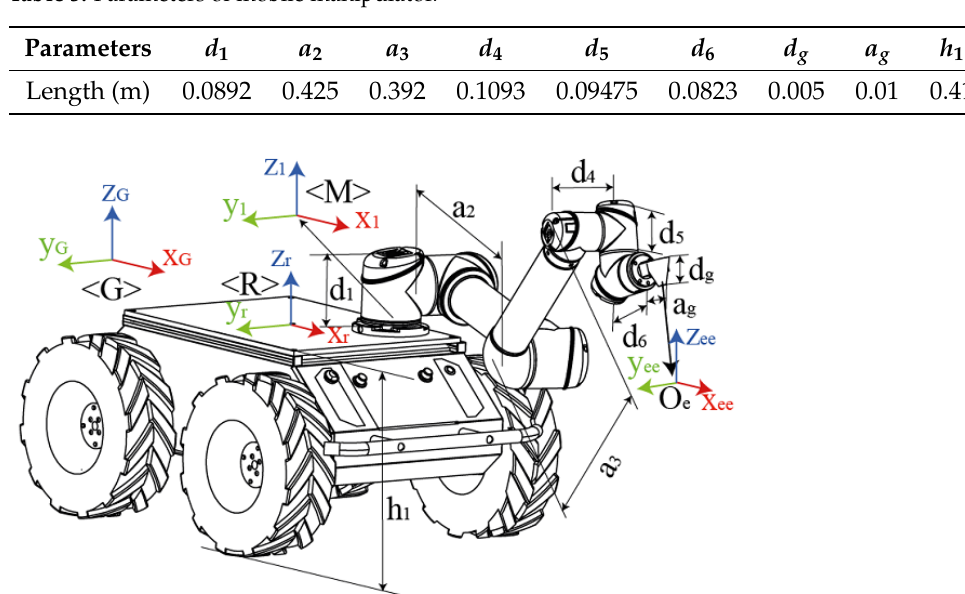
Table 3. Parameters of mobile manipulator.